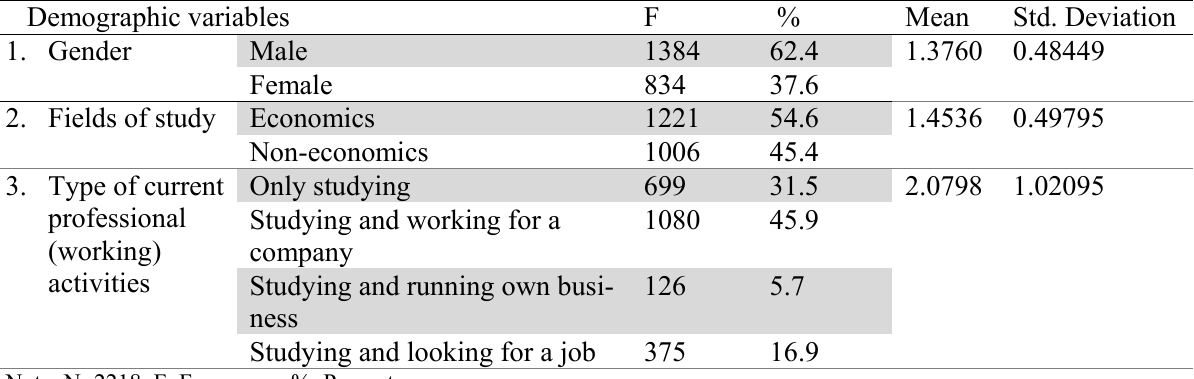
Demographic variables F % Mean Std.